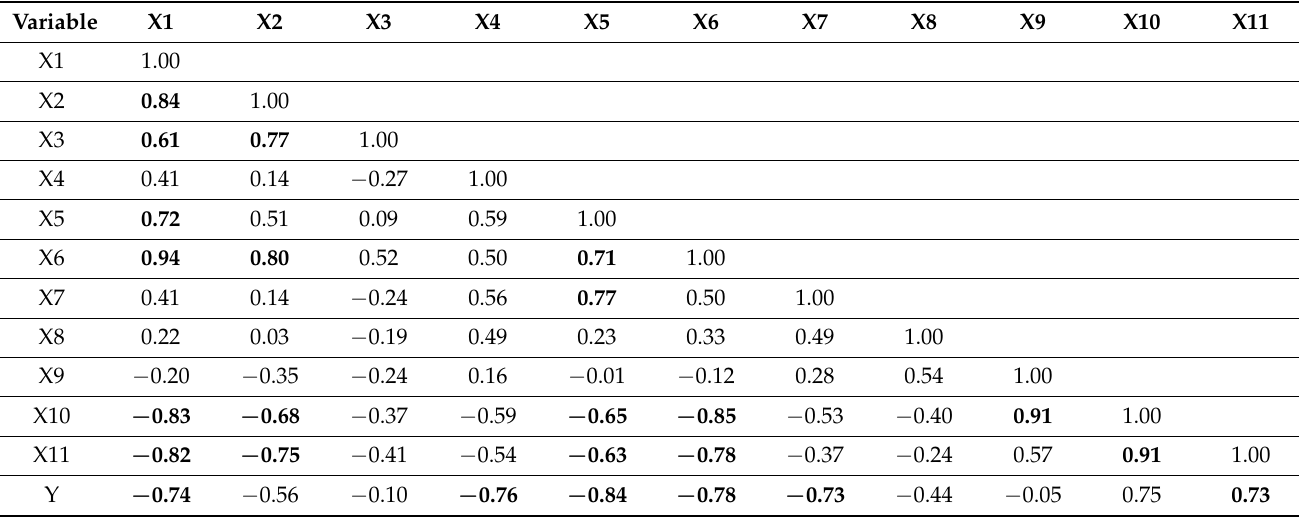
Table 2. Correlation matrix for the variables analysed